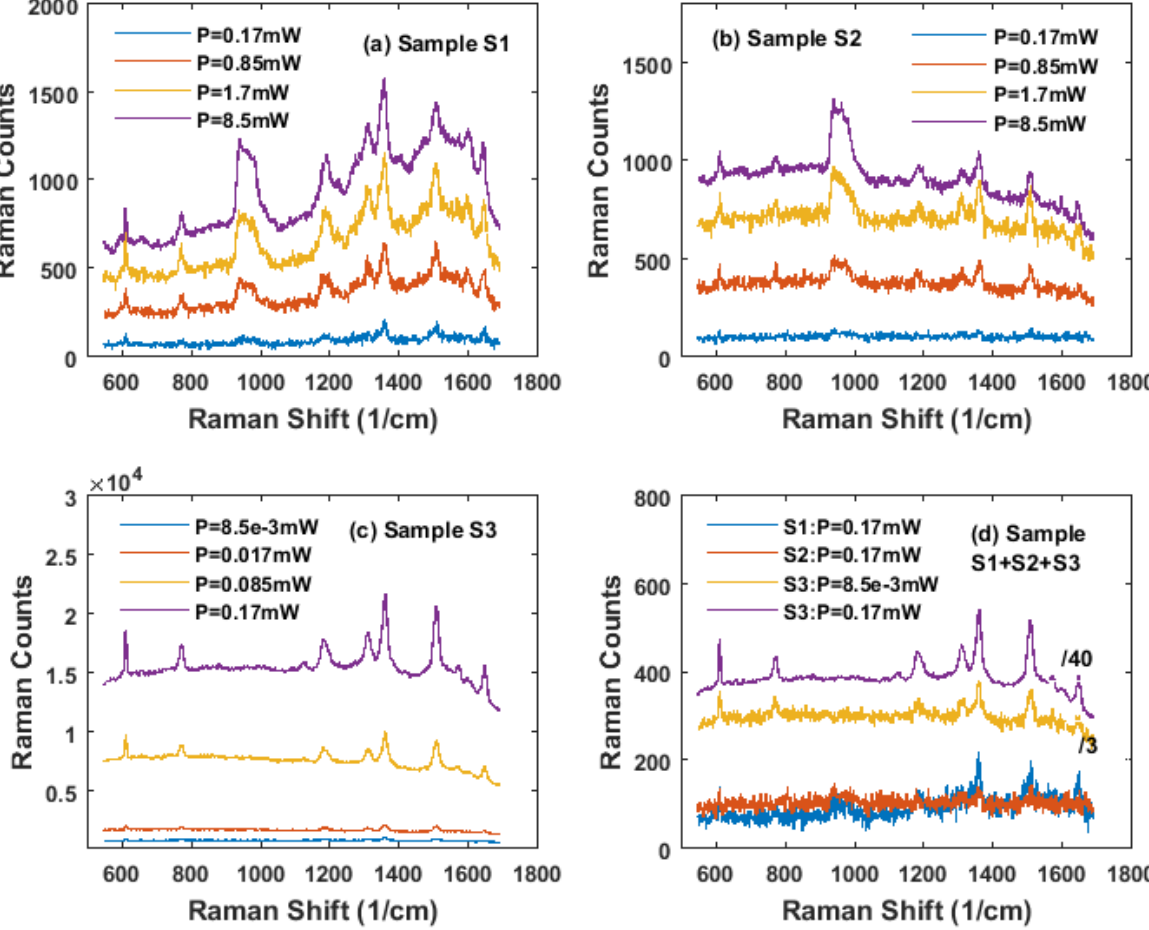
Figure 3. SERS measurement of R6G with a concentration of 1 × 10 − 6 M with different samples. The laser excitation was 633 nm, exposure time was 5 s for all measurements in ( a – d ), and the objective was 50X. For ( a , b ), the measurement taken at different laser powers of 0.17 mW, 0.85 mW, 1.7 mW, and 8.5 mW. ( a ) Sample S1 5 nm evaporated gold thin film on silicon substrate annealed at 600 C for 30 min. (AuNP/Si) ( b ) Sample S2 10 nm evaporated gold thin film on silicon sub- strate annealed at 600 C for 30 min (AuNP/Si). ( c ) Sample S3 10 nm evaporated gold thin film on SiO 2 (10 nm) Au (100 nm) Cr (2 nm) on flat sapphire substrate annealed at 600 C for 30 min (AuNP/SiO 2 /Au/Sapphire). The measurement taken at the different laser powers of 8.5 × 10 − 3 mW, 0.017 mW, 0.085 mW, and 0.17 mW. ( d ) Comparison of Samples S1, S2, and S3 at different laser power in the test. Sample S1 and S2 at p = 0.17 mW, S3 at p = 0.17 mW and p = 8.5 × 10 − 3 mW. The curve